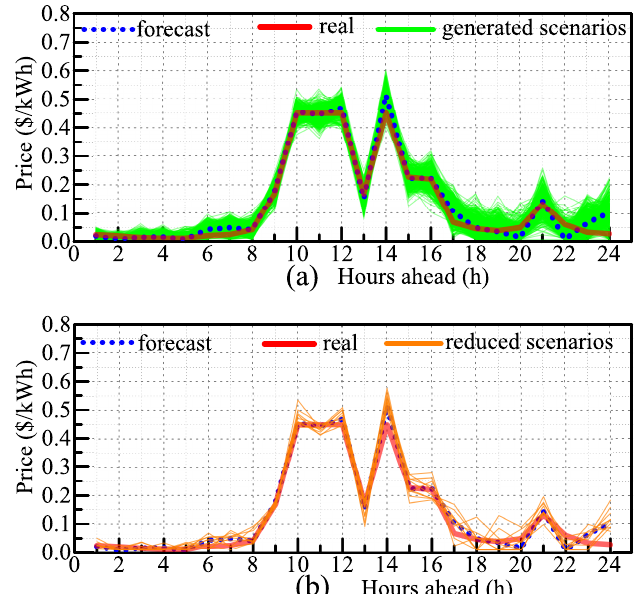
Figure 4. Scenario generation and reduction of price profile for imported power from the utility ( a ) generated 500 imported electricity price scenarios for 24 h ahead with increasing standard deviation; ( b ) reduced set of 10 final scenarios by applying the BRA algorithm to the original 500 scenarios.